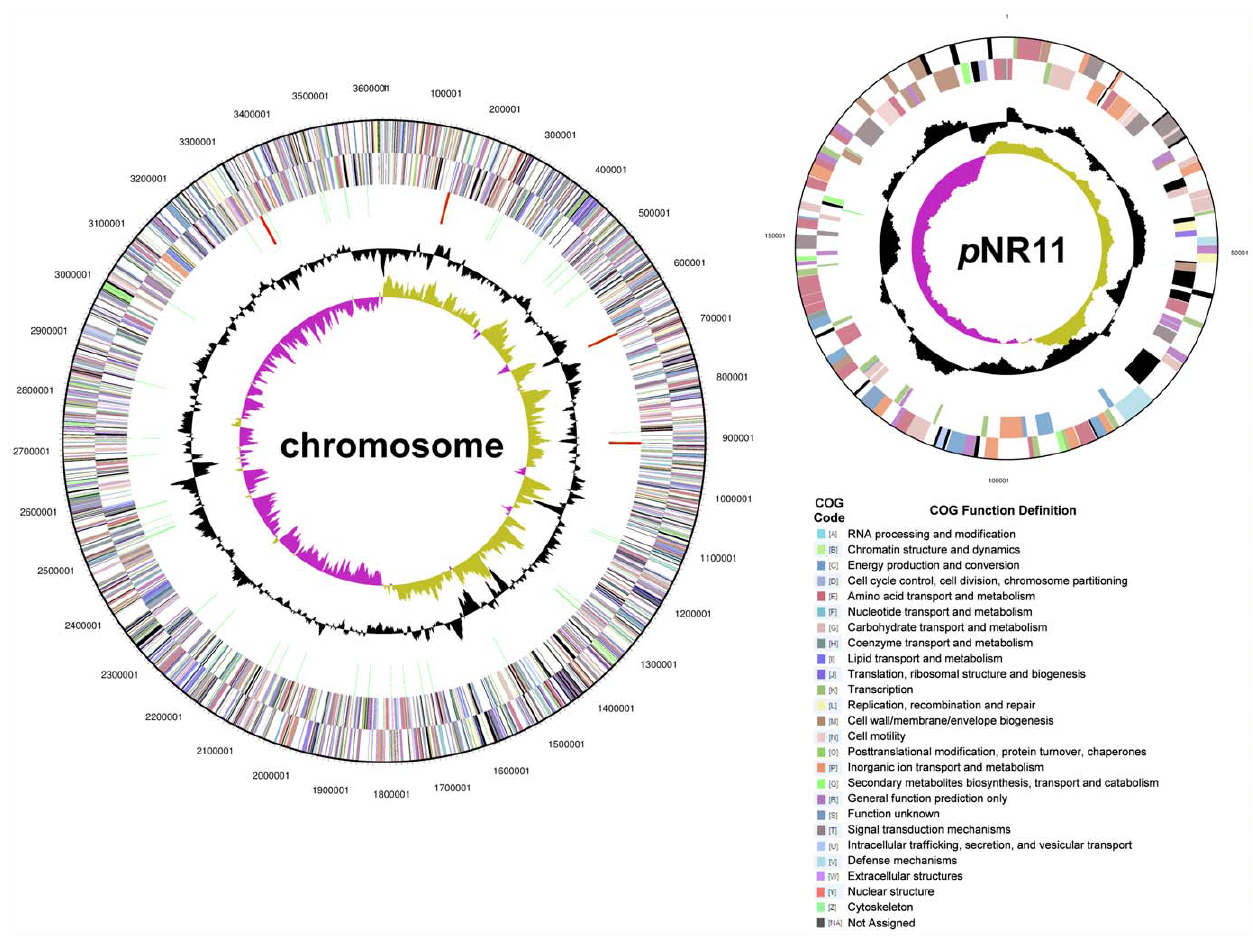
Figure 1. Nautella sp. R11 chromosome and plasmid pNR11. From outside to the center: Genes on forward strand, reverse strand (color by COG categories as indicated), rRNA genes (tRNAs green, rRNAs red, other RNAs black), GC content and GC skew.